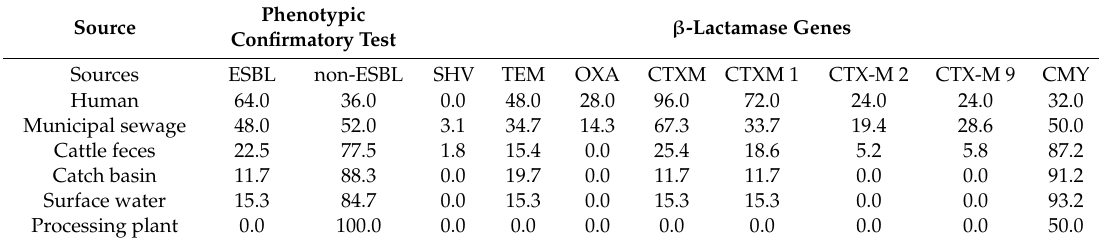
Table 3. Proportion of true ESBL phenotypes and β -lactamase among extended-spectrum cephalosporin- resistant E. coli isolates from multiple